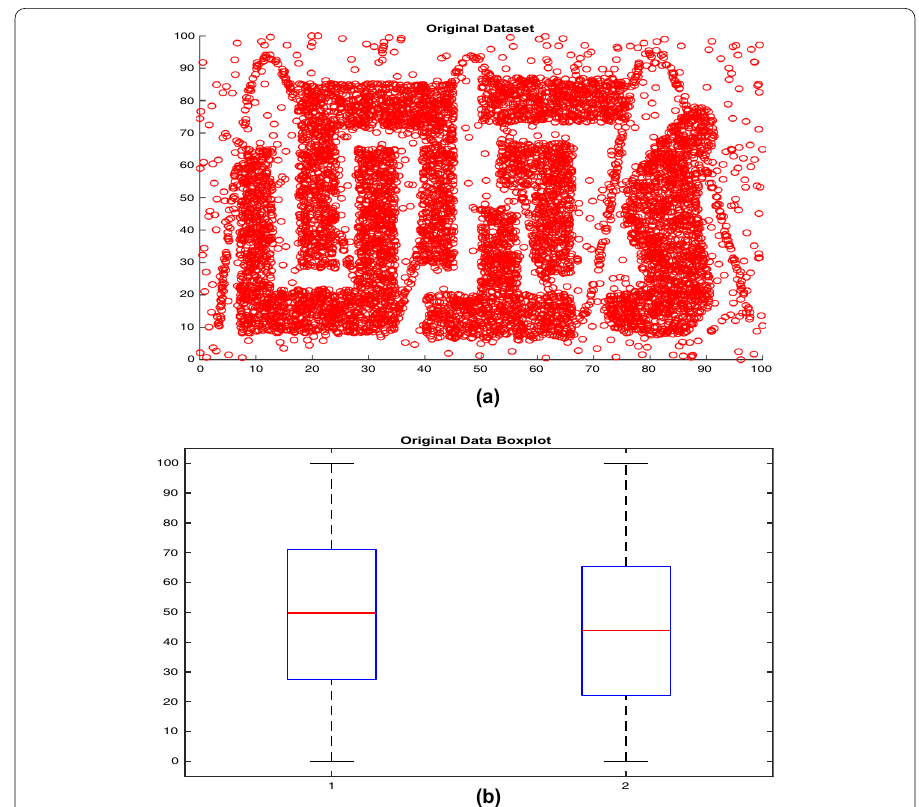
Fig. 4 a Original data representing clusters with different shapes and a mixture of sinusoidal and gaussian noise. b Traditional boxplot showing no